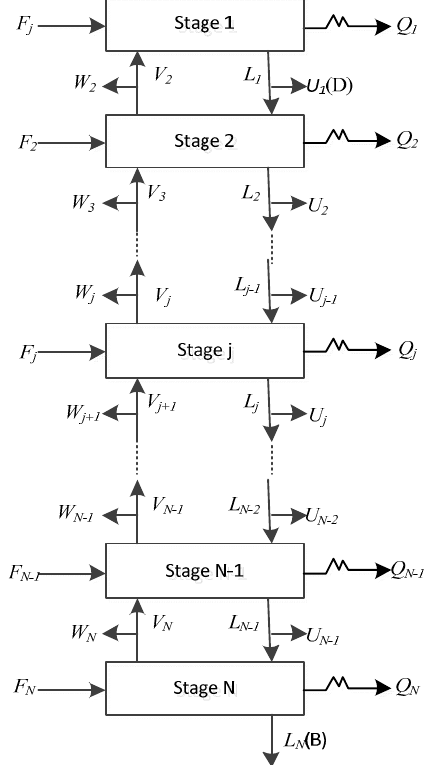
Figure 3. Schematic representation of input and output streams in all stages of a distillation column.